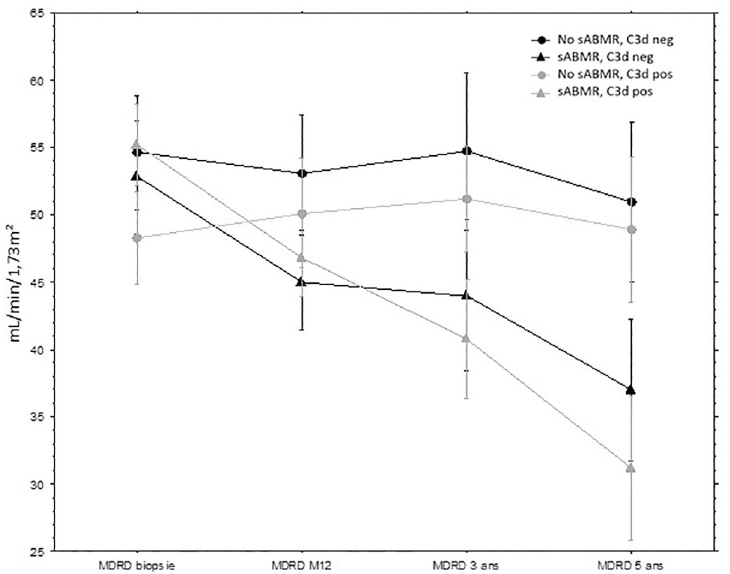
Fig 6. eGFR at 1, 3- and 5-years post biopsy according to the C3d-fixing DSA status in the subset of patients with sABMR or without sABMR. eGFR, estimated glomerular filtration rate; MDRD, Modification of Diet in Renal Disease; sABMR: subclinical antibody mediated rejection; DSA: donor specific antibodies.